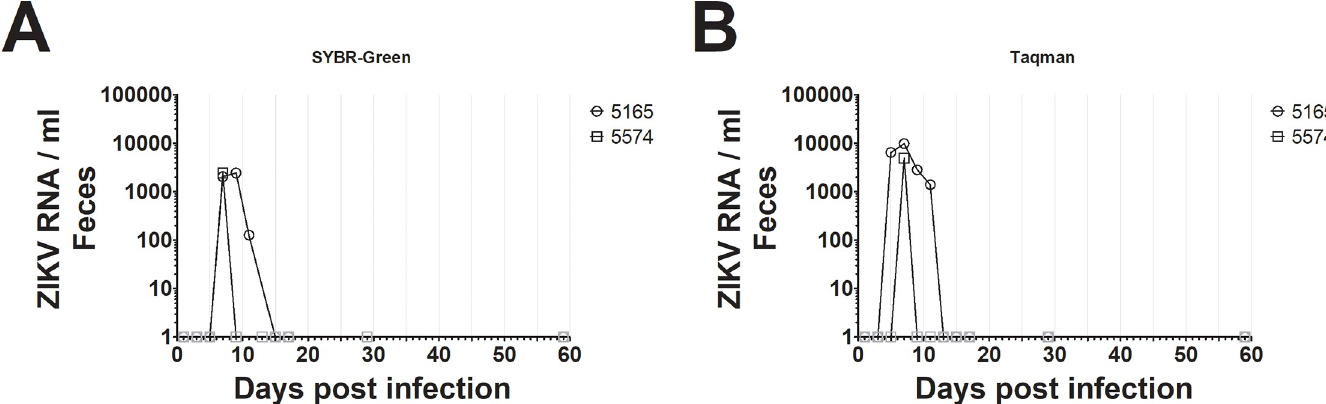
Fig 4. ZIKV was quantified in fecal samples from experimentally infected non-human primates using RT-qPCR. (A) SYBR-green was used to quantify ZIKV in fecal samples. ZIKV was detected between 7–11 dpi. (B) Taqman was used to quantify ZIKV in fecal samples. ZIKV was detected between 5–11 dpi. Gray symbols indicate ZIKV at levels outside the range of the standard curve. No ZIKV was detected at 59 dpi using either SYBR-Green or Taqman, and no ZIKV was detected in feces of uninfected individuals.